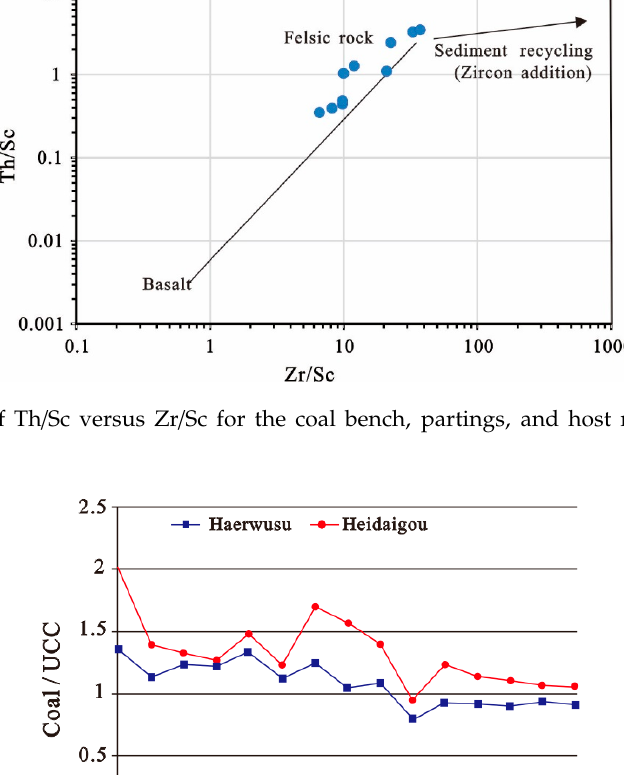
Figure 17. Plot of Al 2 O 3 versus TiO 2 for the coal bench, partings, roof, and fl oor samples from Dongpo Mine.